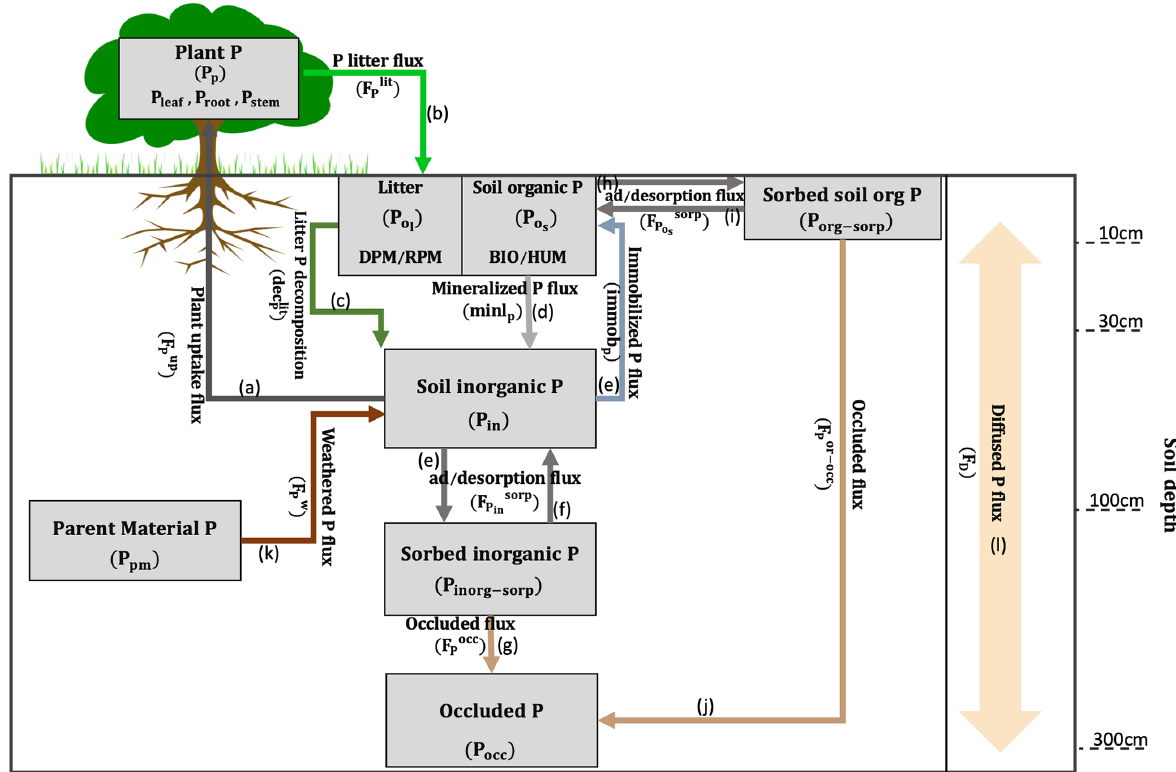
Figure 1. JULES-CNP model scheme including P pools (grey boxes) and fluxes